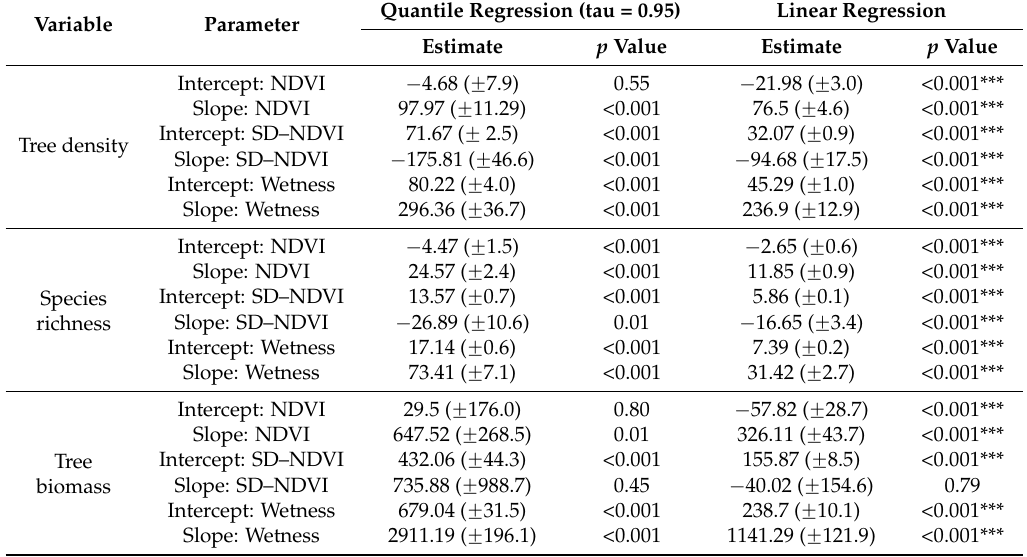
Figure 3. Relationship between tree density (no. of trees/ha), species richness and biomass (kg) with NDVI, SD–NDVI and wetness using quantile regression (0.95 tau) and linear regression. The dashed line is for linear regression and solid line is for quantile regression (0.95 tau). Table 2. Comparison of the results of quantile regression (0.95 tau) and linear regression for the relationship of tree density, species richness and biomass with NDVI, SD–NDVI and wetness.